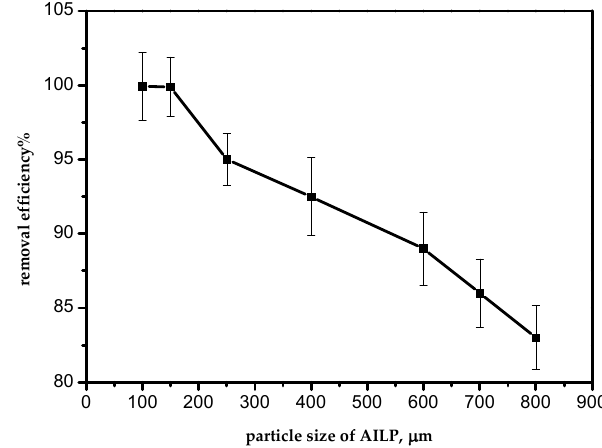
Figure 3. Effect of the adsorbent particle size.